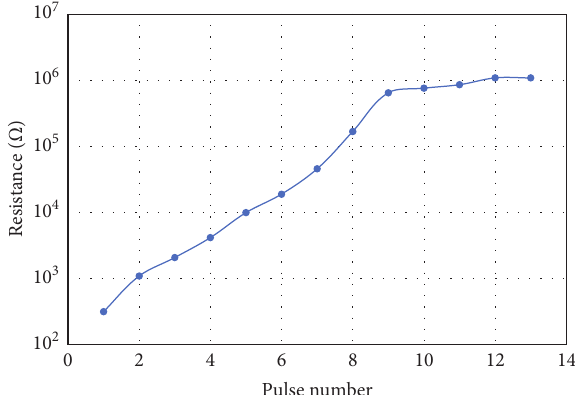
Figure 10: Pulse number vs. resistance curve of simulation